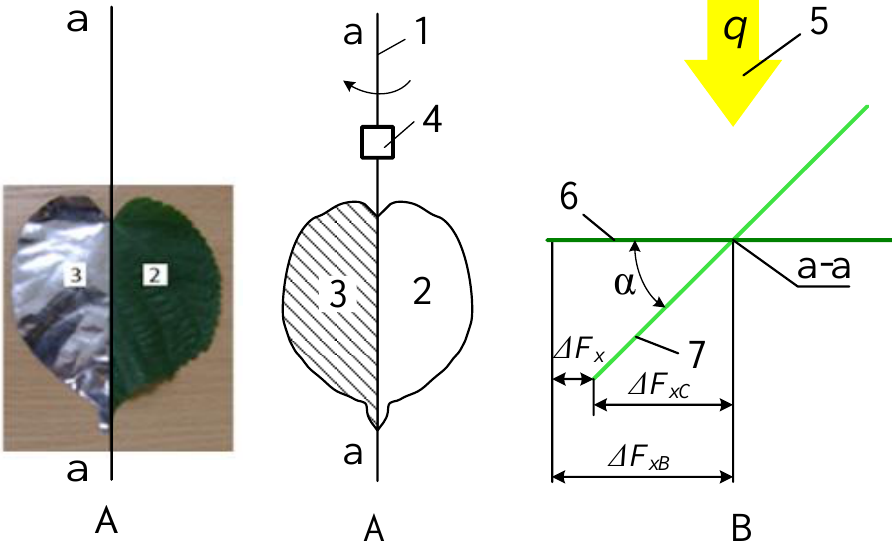
Figure 11. Plant leaf rotation scheme: A—suspended plant leaf; B—heat flow change with plant rotation evaluation diagram; a–a—leaf suspension (rotation) axis; 1—a metal filament from a galvanometer; 2—active leaf blade surface area; 3—surface area of a leaf blade covered with heat reflecting coating; 4—light wave reflection mirror to measure the rotation of the leaf; 5—heat flux q ; 6—plant leaf position (initial) perpendicular to the heat (light) waves; 7—plant leaf position after rotation at angle α